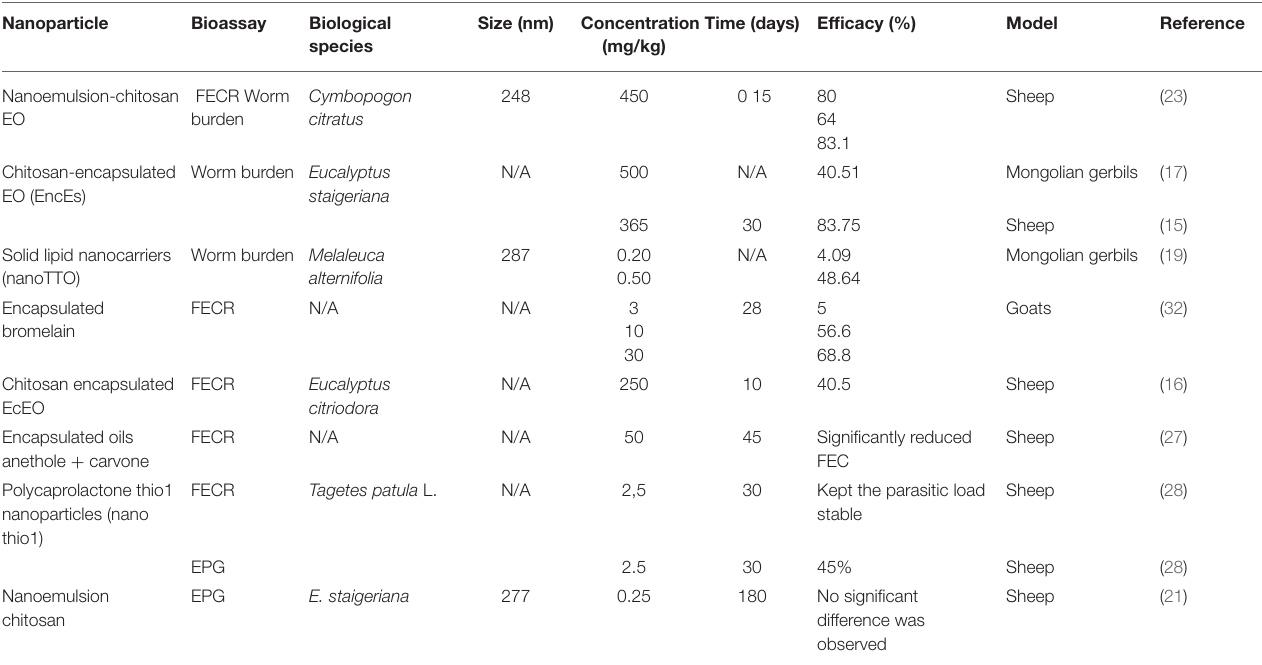
TABLE 3 | In vivo efficacy of nanoparticles against H. contortus